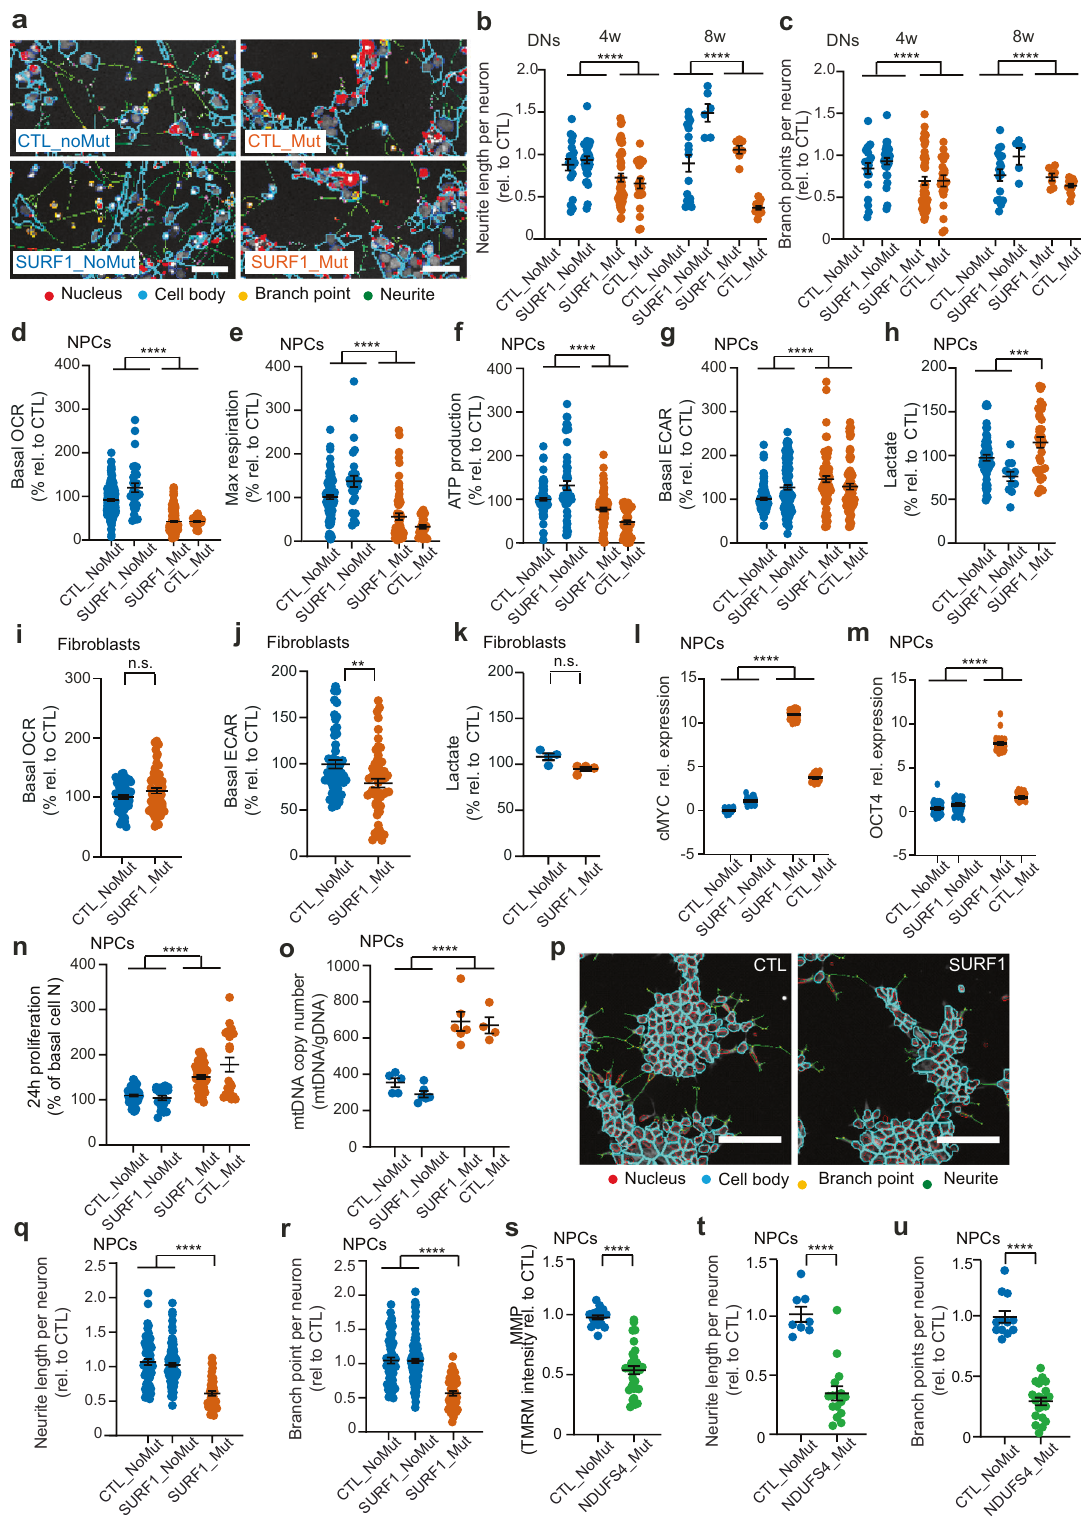
( MKI67, CENPE, CRABP2 , MYC, LDHA, POU5F1 ) (Fig. 6a, Supplementary Fig. 6b, Supplementary Data 11). Genes of community 3 related to neuronal function were mainly down- regulated in SURF1 organoids, including axon guidance genes ( CHL1, GAS7, RELN, SEMA3C, SLIT2 ), and glial and neuronal development genes and synaptic genes ( SYT14 , CDH6,